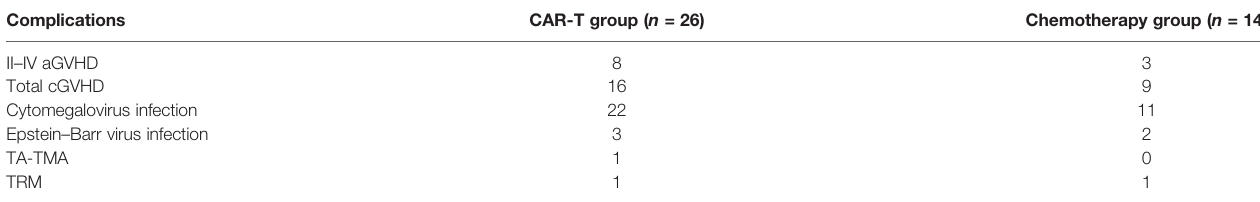
CAR-T, chimeric antigen receptor T cells; GVHD, graft-versus-host disease; TA-TMA, transplantation-association thrombotic microangiopathy; TRM, treatment-related